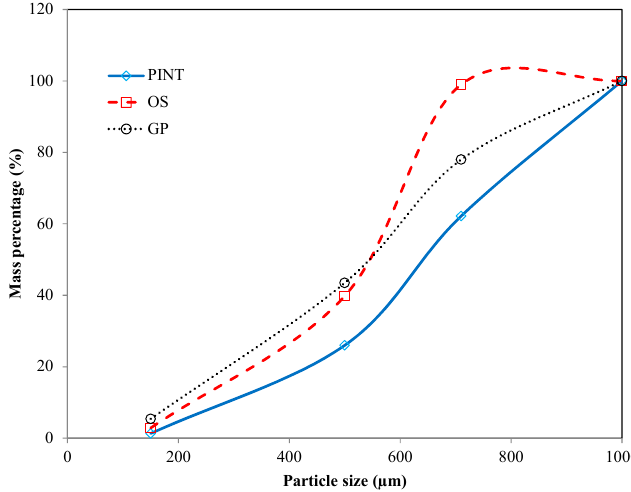
Figure 6. Cumulative particle size distribution of the biomass samples used for mixtures.